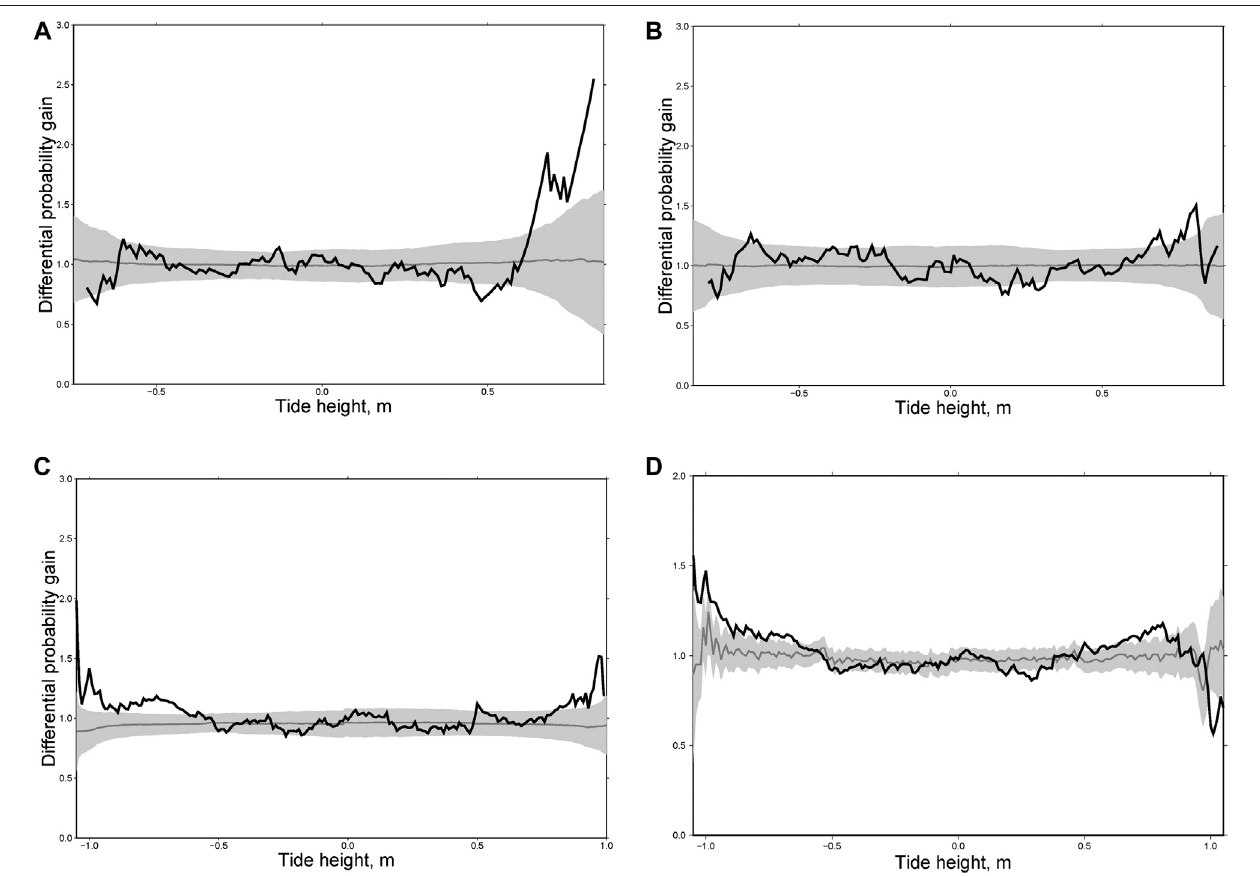
FIGURE 12 | The differential probability gain functions for three aftershock sequences in New Zealand following the strike-slip earthquakes of M (cid:1) 6.4, May 25, 1981 (A) ; M (cid:1) 6.7, December 30, 1984 (B) ; M (cid:1) 6.5, July 21, 2013 (C) ; and integral differential probability gain function for four sequences from strike-slip earthquakes (D)